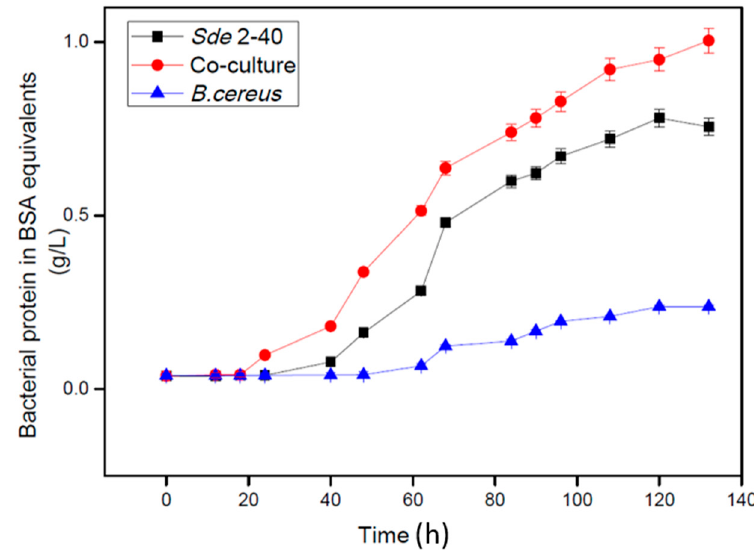
Figure 3. Growth profiles of Sde 2-40, B. cereus , and co-culture on 1% ( w / v ) xylan.